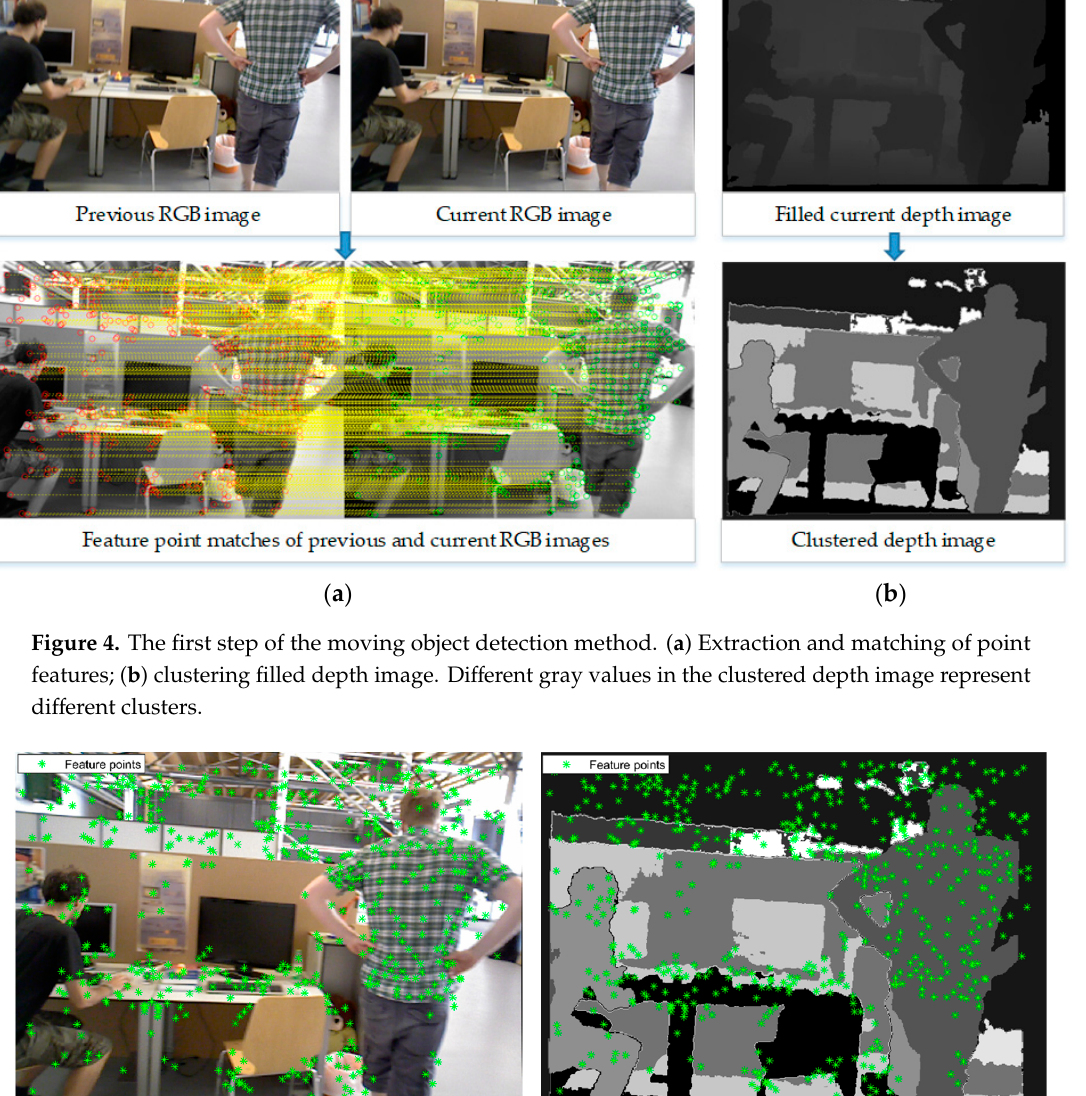
Figure 5. The second step of the moving object detection method. ( a ) The position of feature points on the current RGB images; ( b ) mapping the positions of feature points onto the clustered depth map. The star symbols represent the feature points. Different gray values represent different clusters.